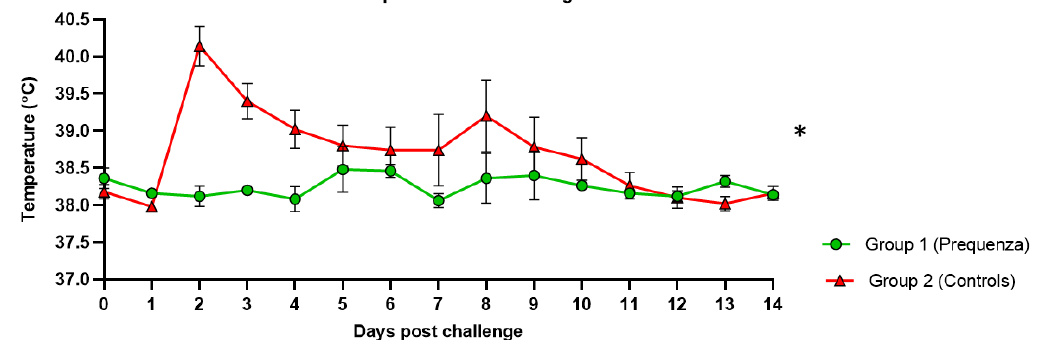
Figure 2. Rectal temperature in groups 1 and 2 after challenge with H3N8 A / equine / Venlo / 19 (FC1 sub-lineage). Green square = group 1, Equilis Prequenza vaccinated group; red triangle = group 2, unvaccinated control group. Error bars represent SEM. Inferential statistics: significant di ff erence ( p < 0.05) between groups 1 and 2 (*) (mean e ff ect between 1 and 14